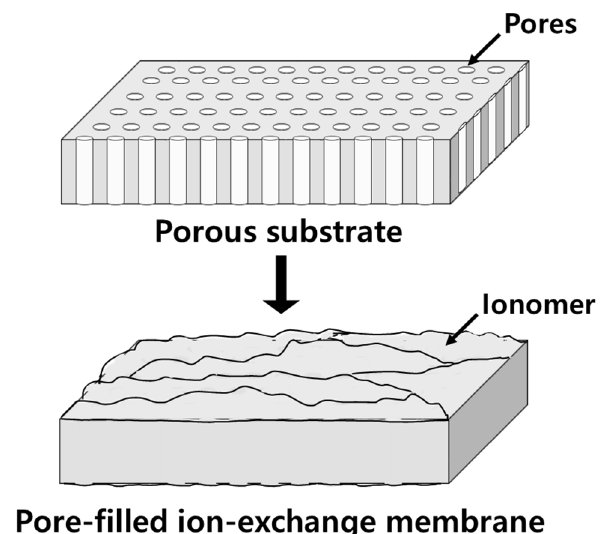
Figure 2. Schematic drawing of PFIEM fabrication.